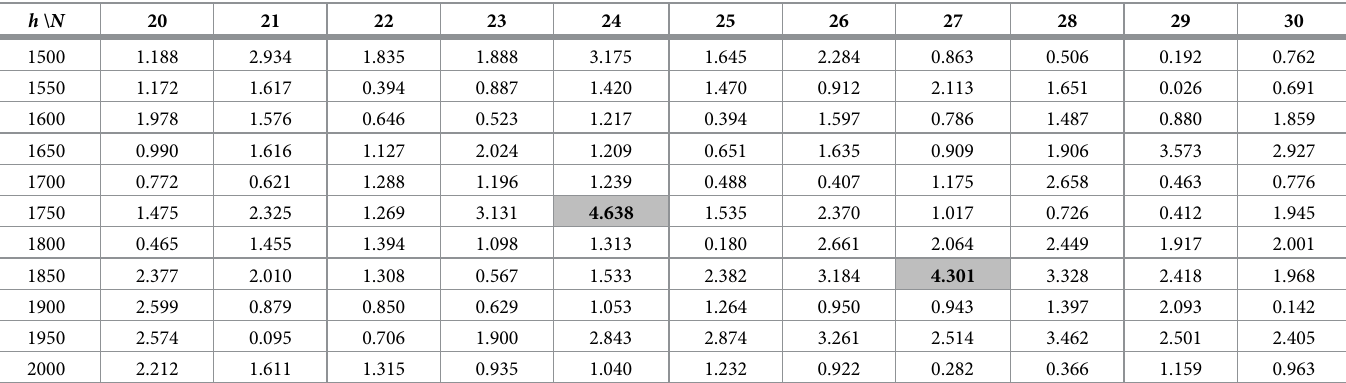
Table 3. Difference between the estimated Hurst exponent of mung beans (B) and reference signal (R) as ( − log 10 p )-values of likelihood ratio test (15). h \ N